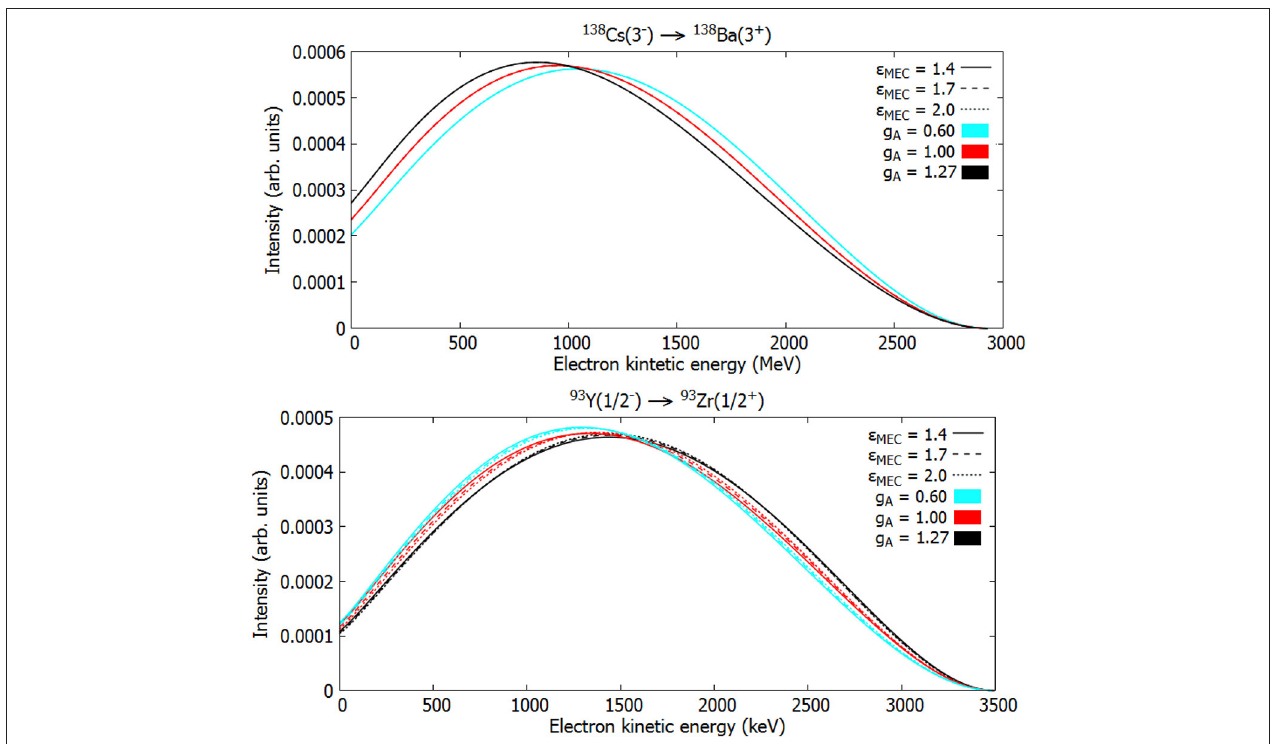
1.0 was assumed and the =